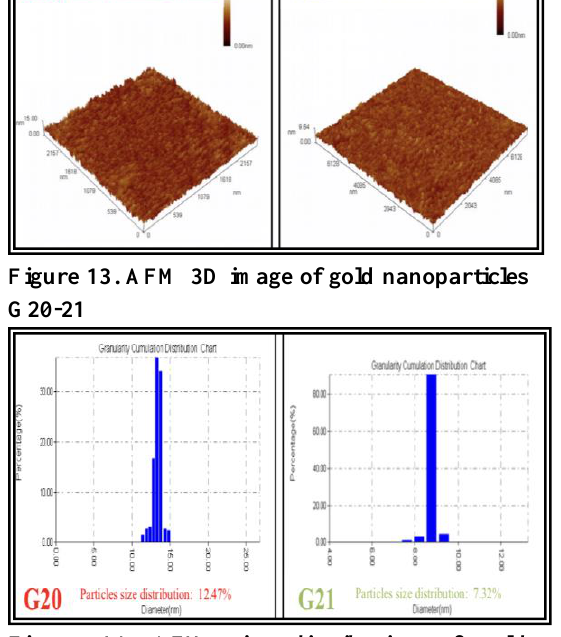
Figure 14. AFM size distribution of gold nanoparticles G20-21 Zeta potential measurement